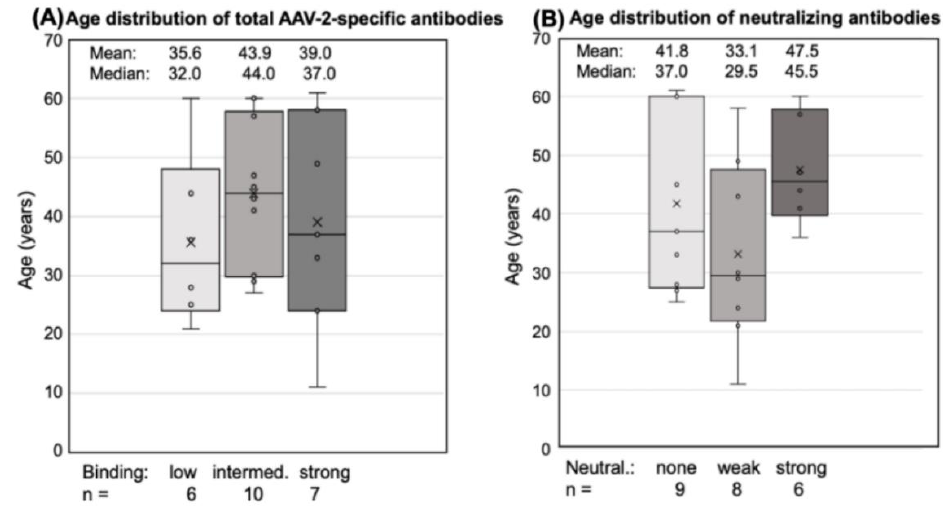
Figure 2. Age distribution of antibody responders. Total antibodies and neutralizing antibodies are shown for each donor. The small circles represent the individual data points, the central line shows the median, the x represents the mean, and the whiskers above and below display the minimum and maximum within 1.5 interquartile range (IQR) of the lower and upper quartile. ( A ) Total AAV2- specific antibodies: “low” binding was defined as mean OD 450 < 0.1 at 1:400 dilution, “intermediate” binding as a mean 0.1 < OD 450 < 0.24, and “high” binding as >0.24. ( B ) Neutralizing antibodies: “weak” neutralization needed 1:50 to <1:300 dilution at 50% neutralization, “strong neutralization” was defined as a serum dilution >1:300. Statistics were performed using the Friedman test and Dunn´s Multiple Comparison test; significant differences were not observed.